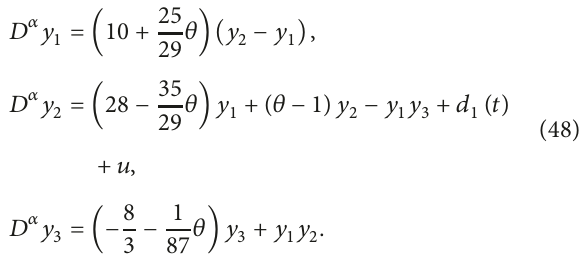
Figure 2: The time response of states 𝑥 1 ,𝑥 2 ,𝑥 3 of system (47) with controller (27).